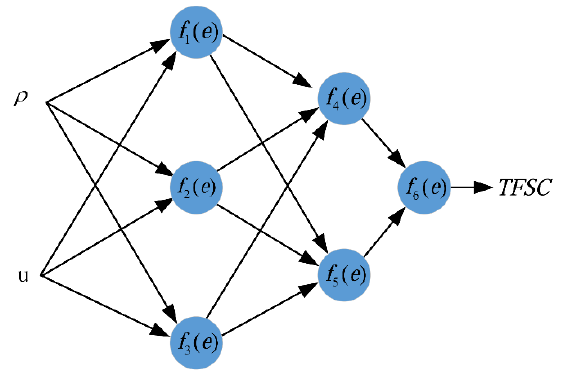
Figure 10. Artificial neural network structure.